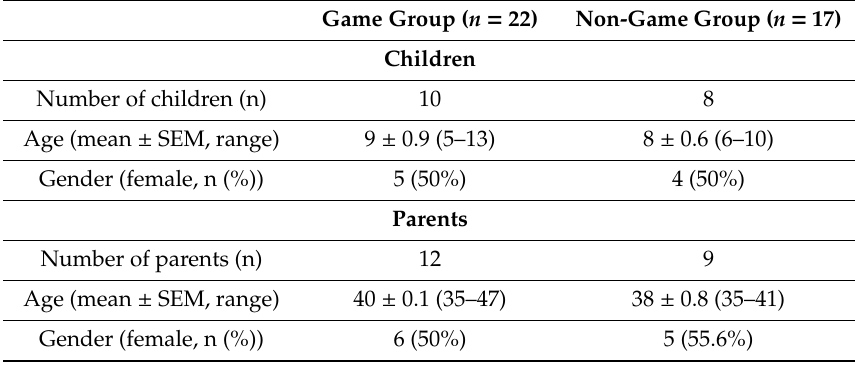
Table 2. Age and gender distribution of participants who completed both baseline and follow up